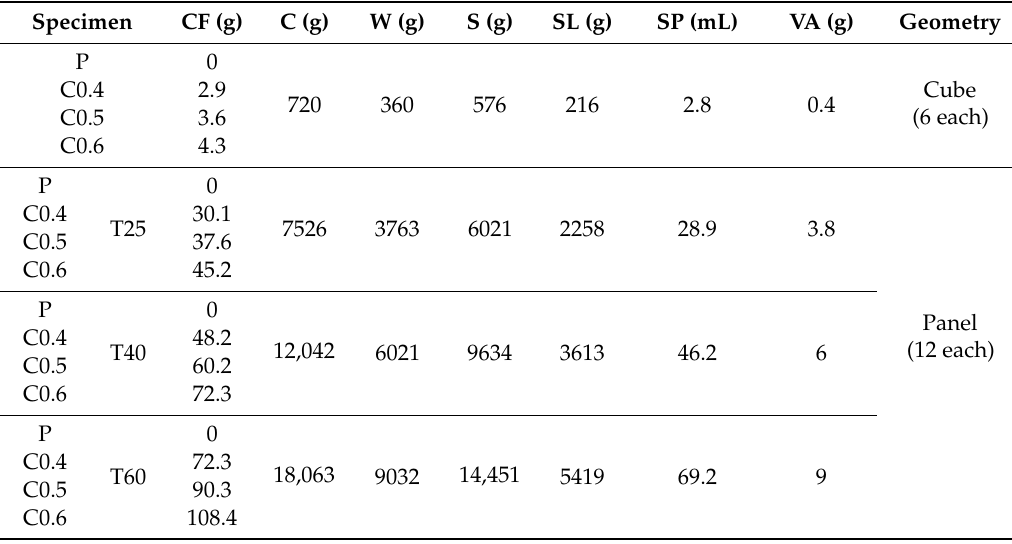
Table 2. Mix design for pitch-based carbon fiber-mortar